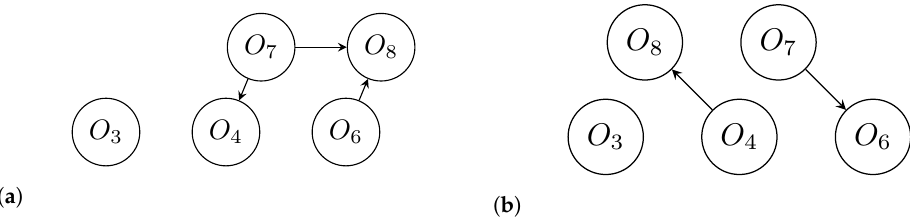
Figure 5. Strong and weak outranking graphs for the second iteration in the forward procedure. ( a ) Strong outranking graph G F